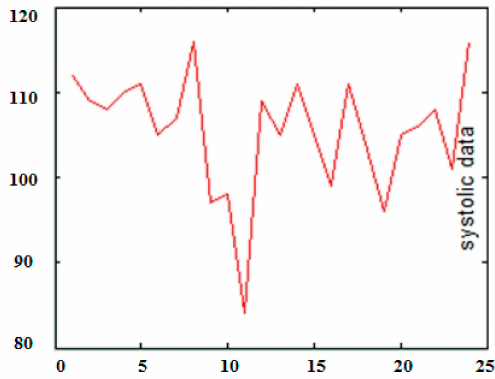
Figure 20. The input data for